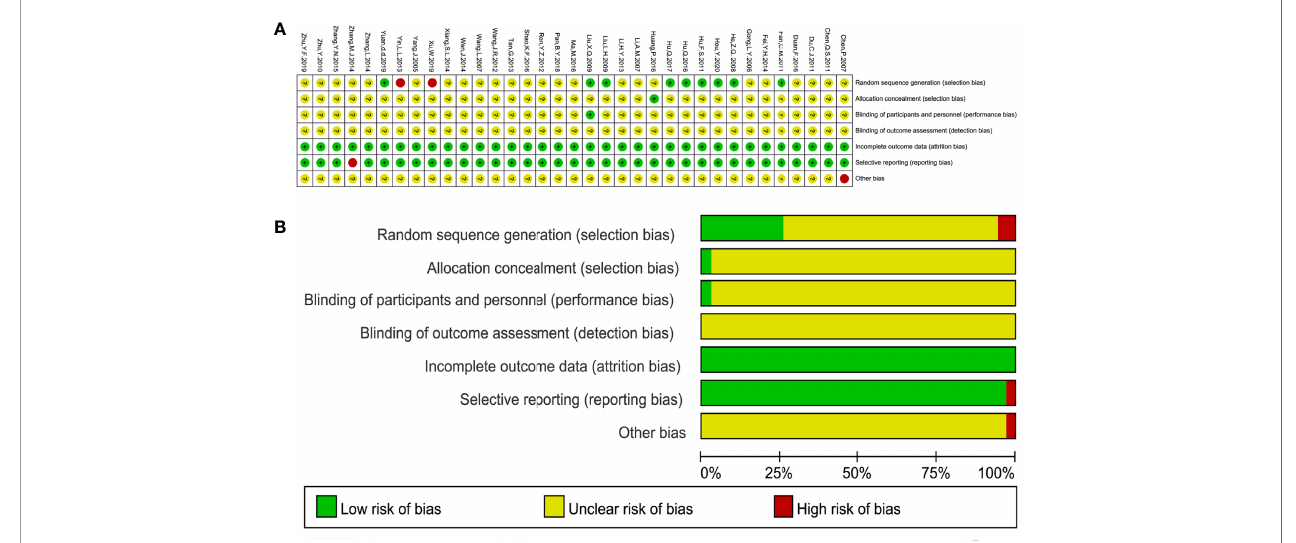
FIGURE 2 | Risk of bias summary and diagram. (A) Risk of bias summary. (B) Risk of bias